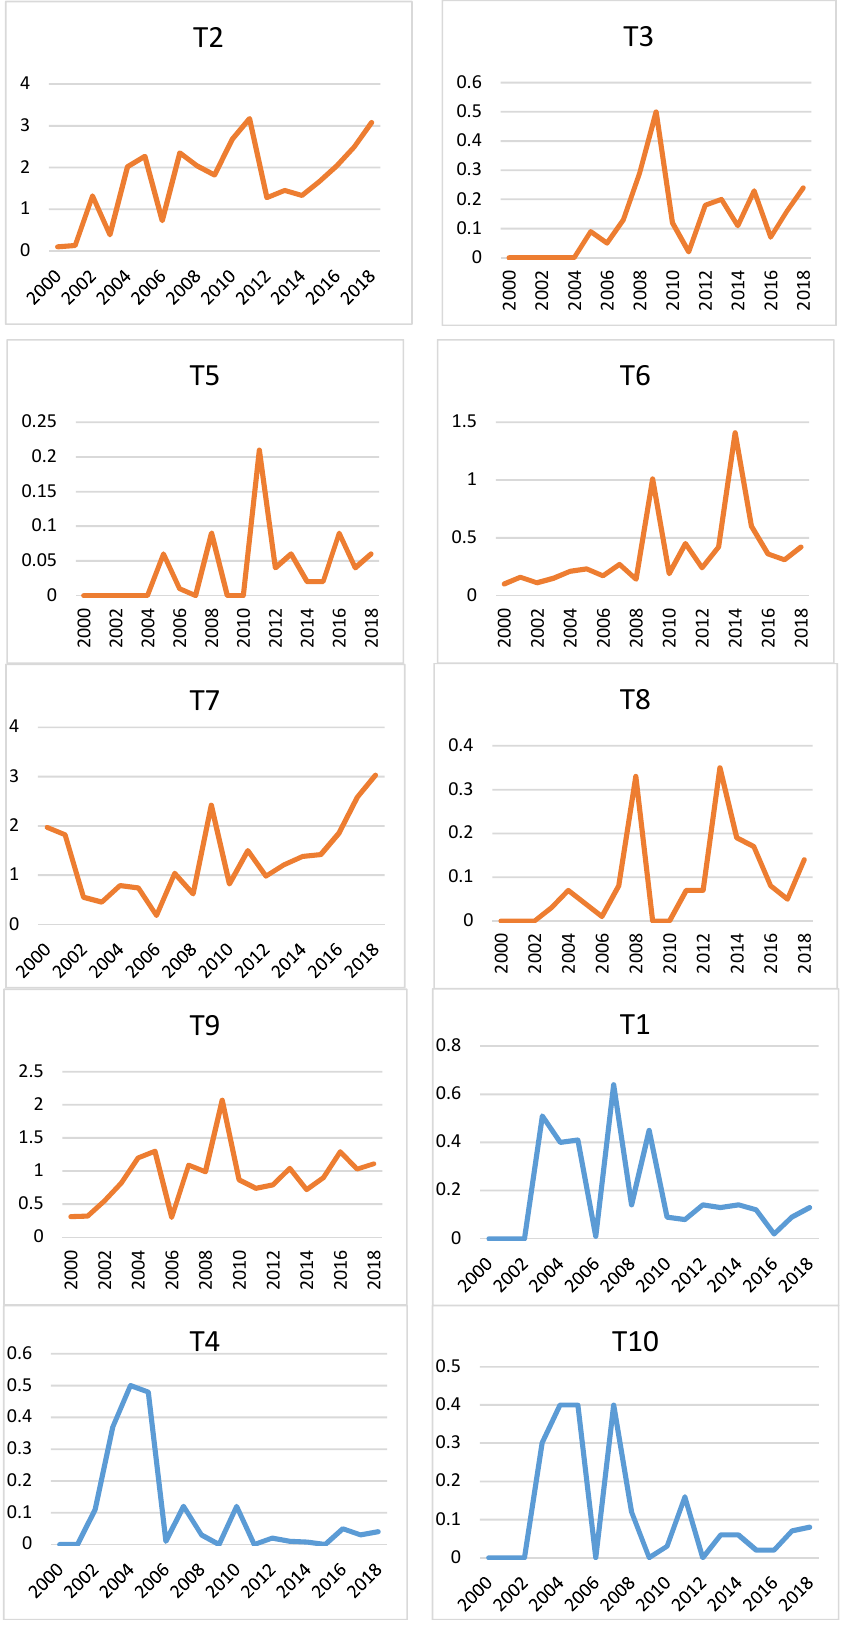
Figure 5. Proportion trend of hot/cold topics.